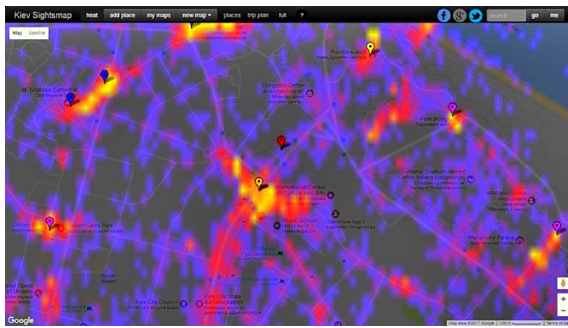
Figure 1. A fragment of a heatmap (the central part of Kyiv) (Sightsmap, 2017)